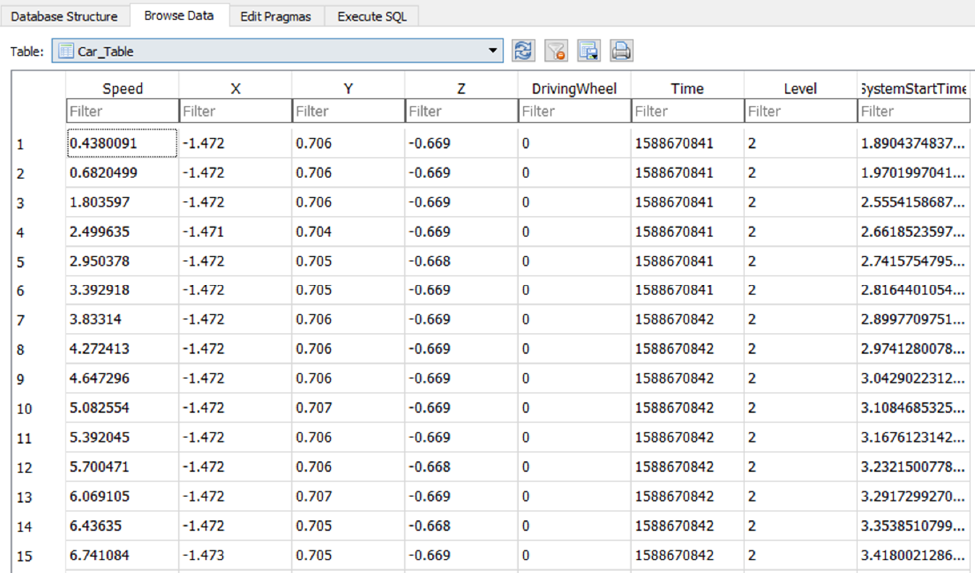
Figure 6. Example of VRET’s system database storage.